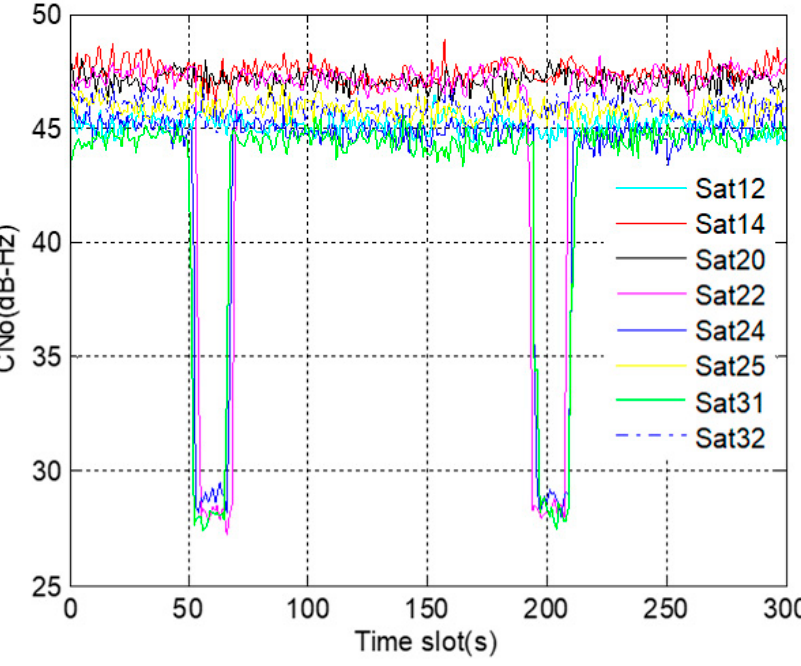
Figure 13. C / No of GNSS